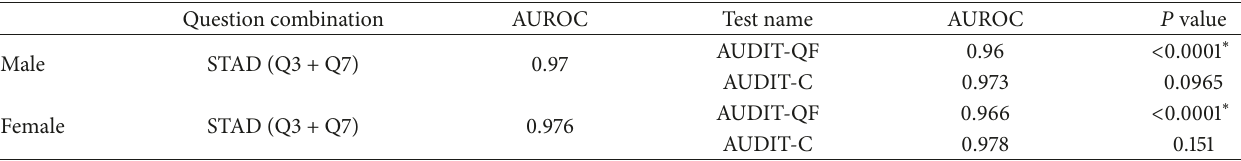
Table 4: Comparison of AUROCs between STAD and abbreviated version of the AUDIT in KNHANES